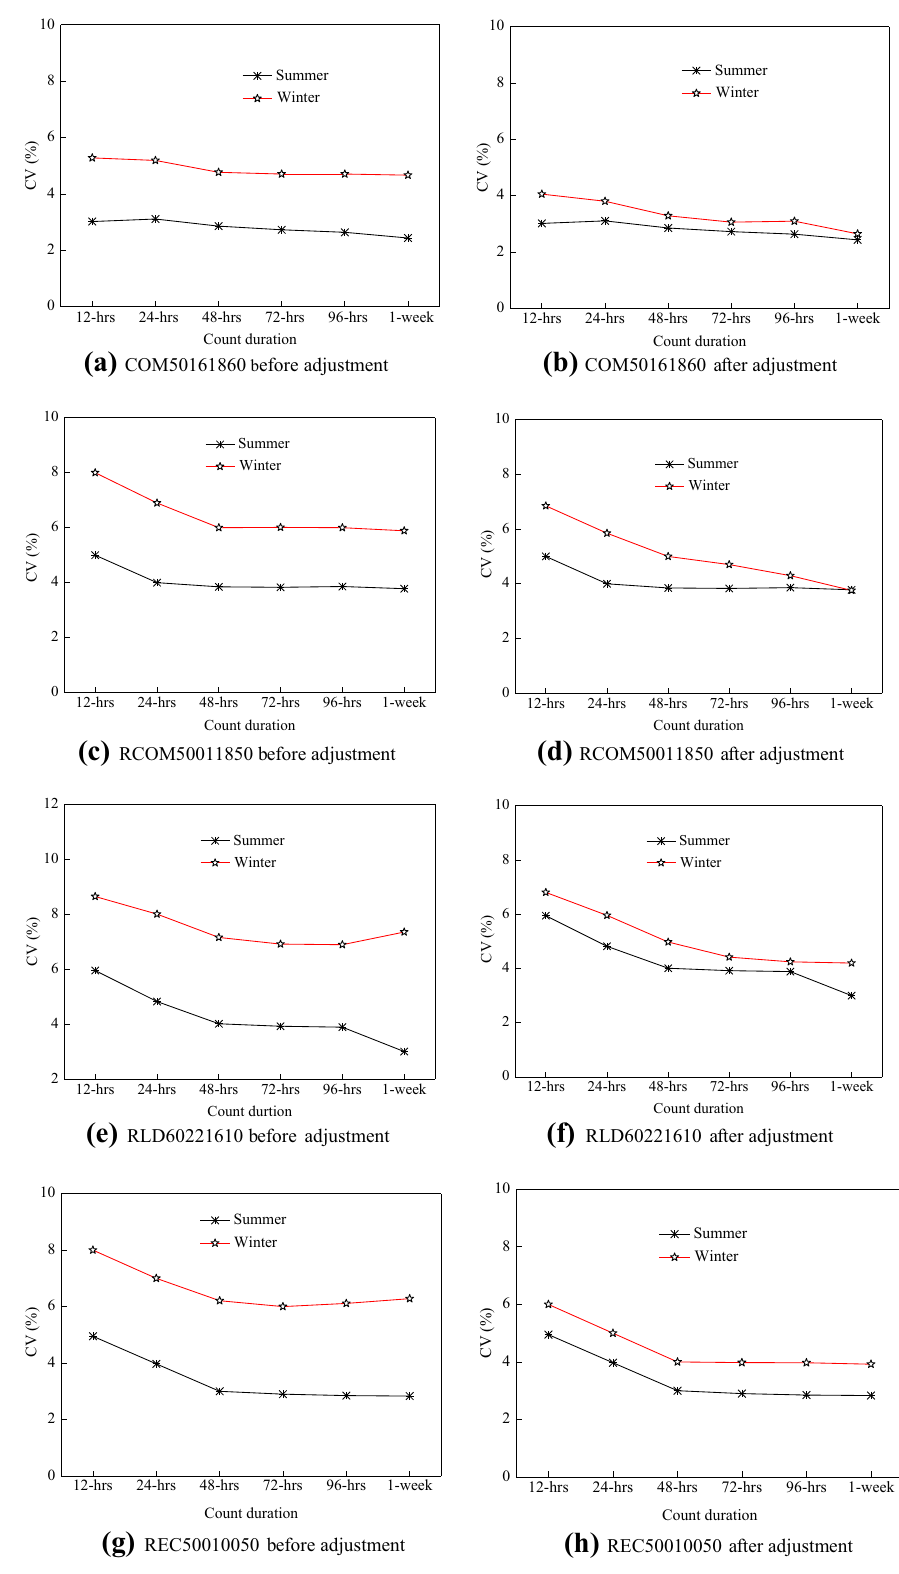
Fig. 6 Summer and winter CV values before and after